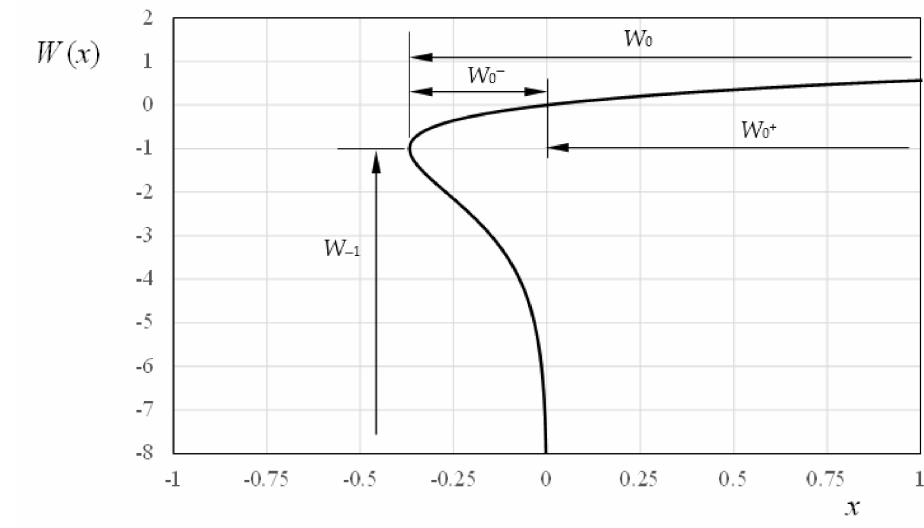
Figure 3. The Lambert W-function, with its two different